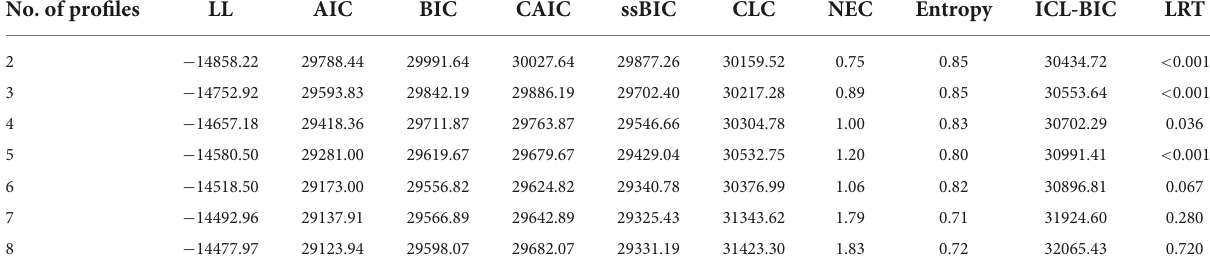
TABLE 2 Model fit indexes for latent profile